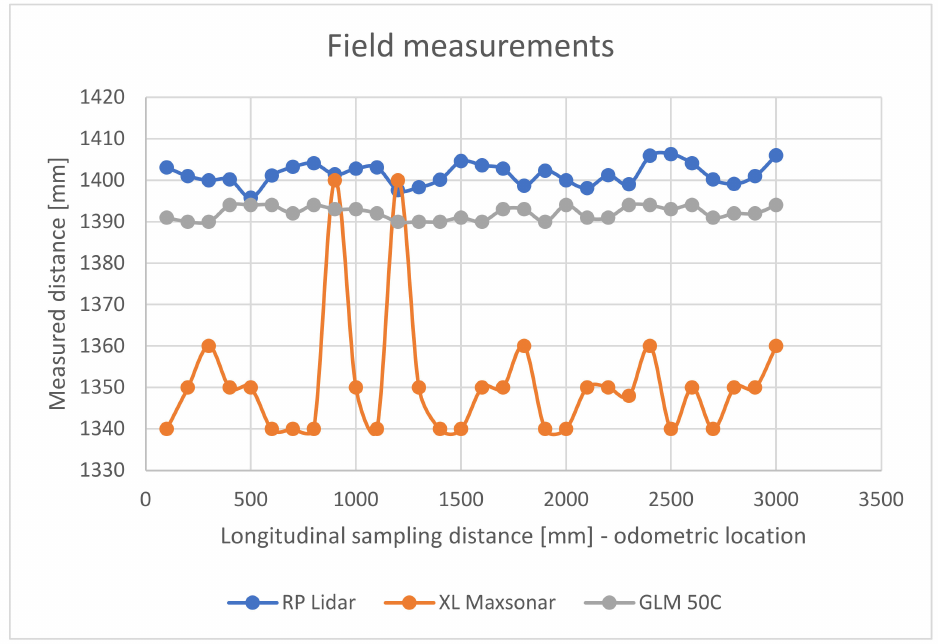
Figure 10. Diagram showing the variation of distance measurements between three